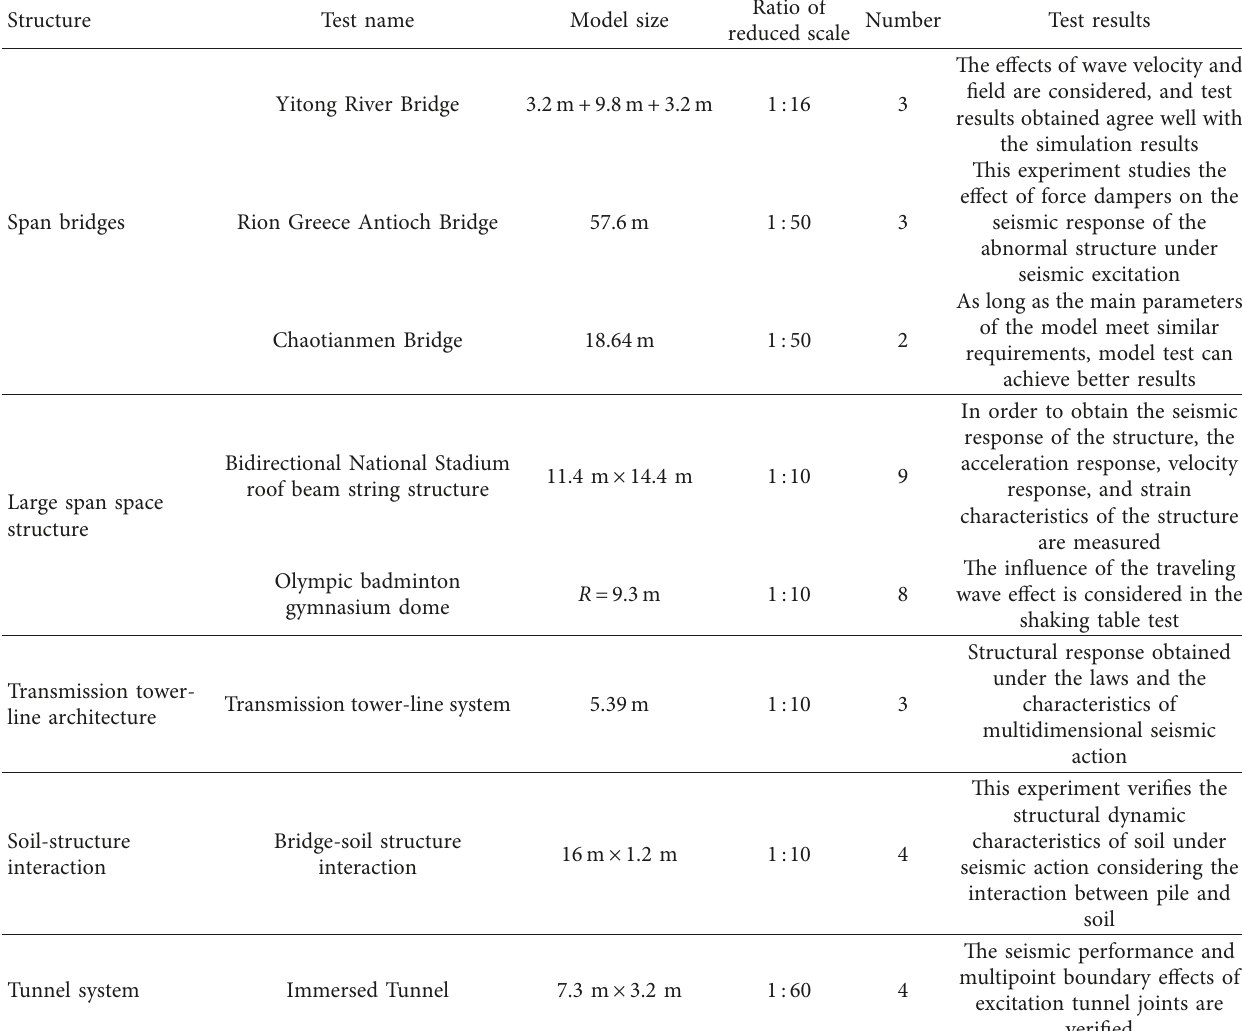
Table 5: Typical array shaking table